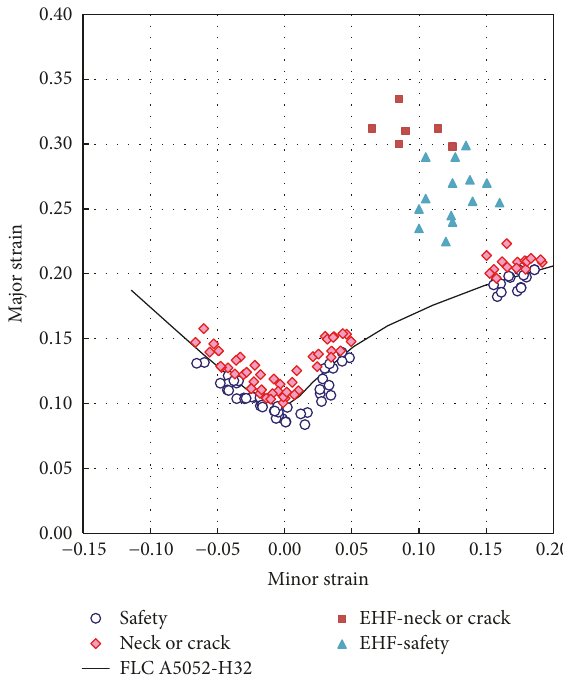
Figure 9: Combined formability results for A5052-H32, 0.5